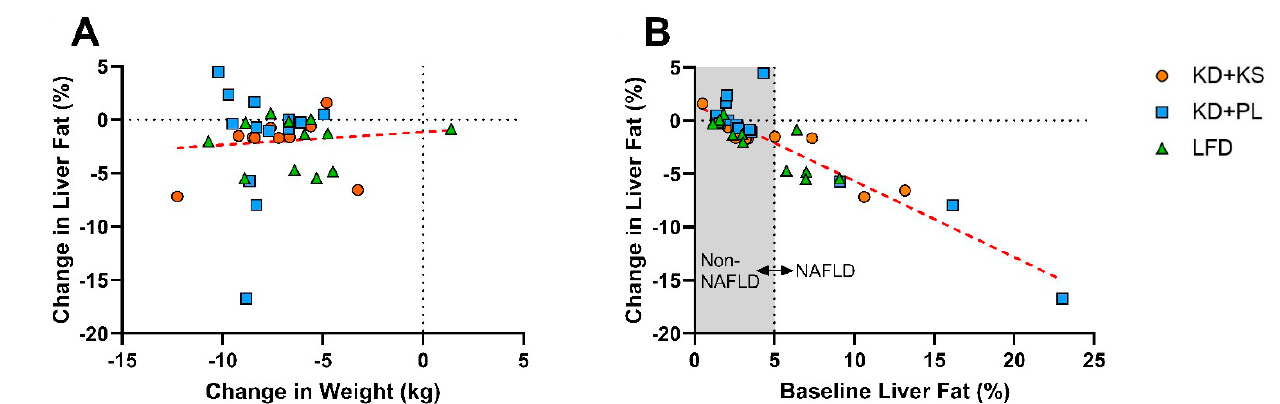
Figure 3. ( A ) Association of the absolute change in liver fat versus weight loss (R = 0.006, p > 0.05). ( B ) Association of the absolute change in liver fat versus baseline liver fat (R = − 0.91, p < 0.05). Within the NAFLD group, the correlation was R = − 0.96 for the ketogenic group ( n = 7) and R = − 0.40 for the low-fat diet group ( n = 5).